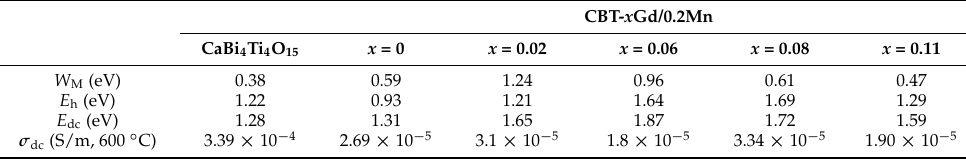
Table 2. Electrical conduction parameters of the CBT- x Gd/0.2Mn